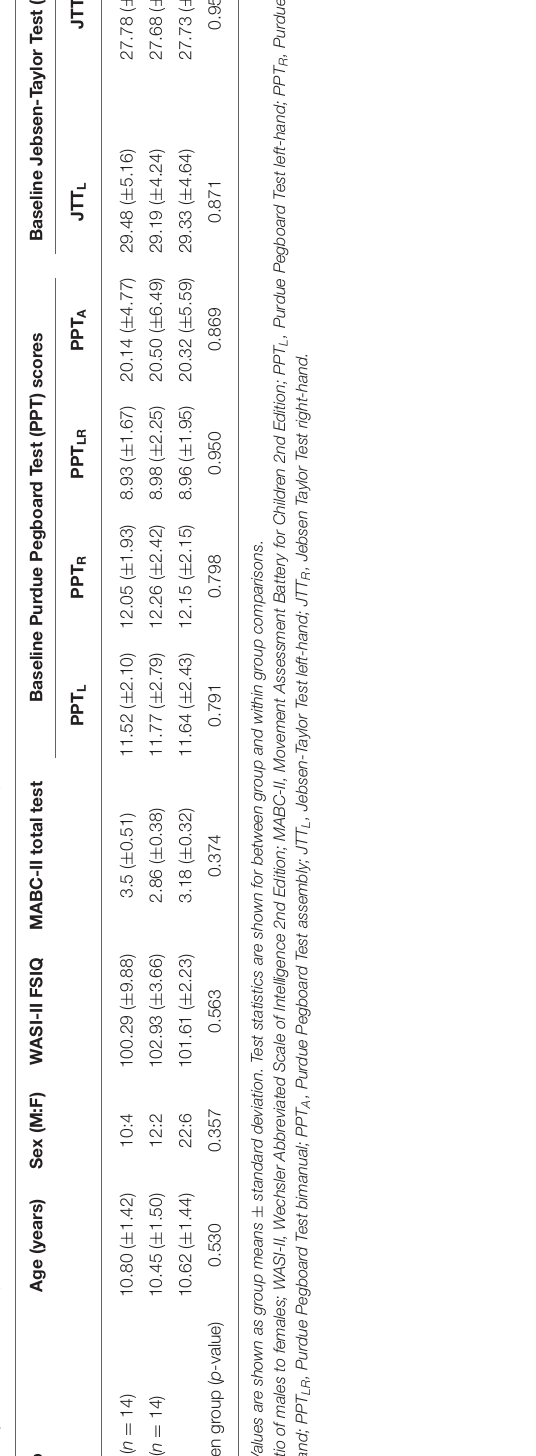
Learning Anxiety Prescribed disorder disorder disorder medications